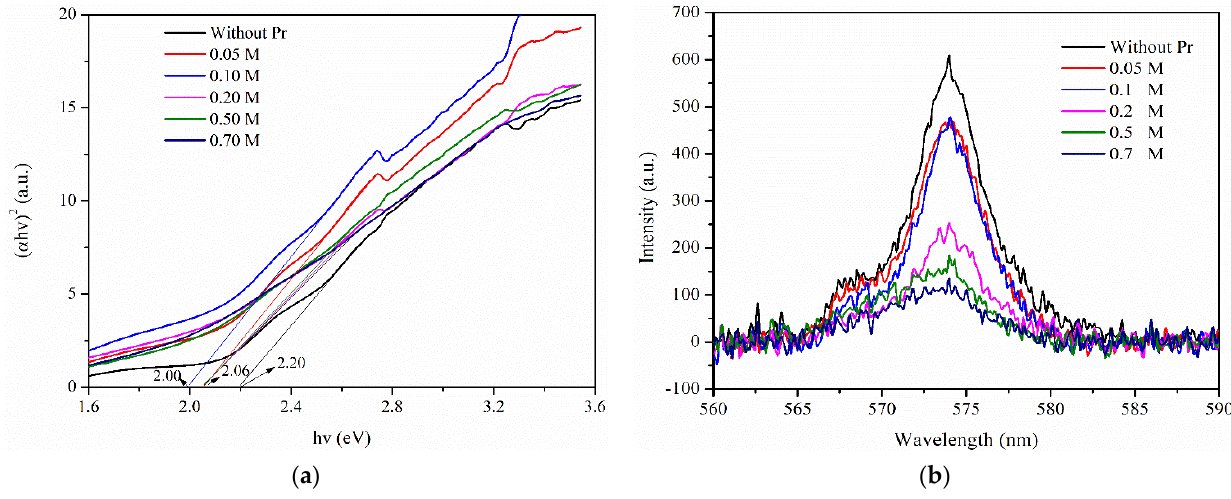
Figure 7. ( a ) UV–Vis DRS spectrum and ( b ) photoluminescence spectra of different concentrations of Pr doping in LaFeO 3 .